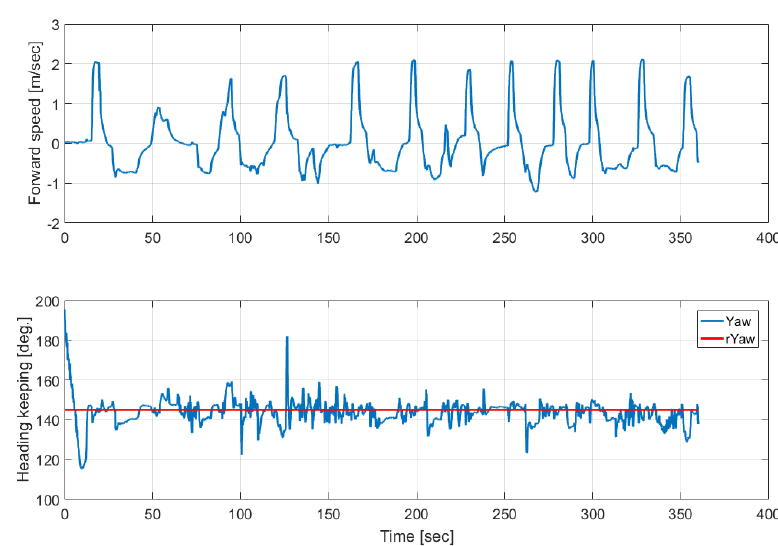
Figure 10. Experimental result of maximum forward speed with heading keeping.